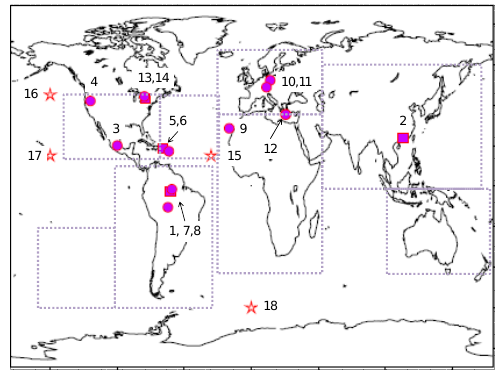
Fig. 4. Summary of the regions used in the consideration of re- gional values (large dashed boxes) and the approximate location of the field observation sites (over-plotted circles and squares). Stars represent additional regions taken for vertical profile plots.